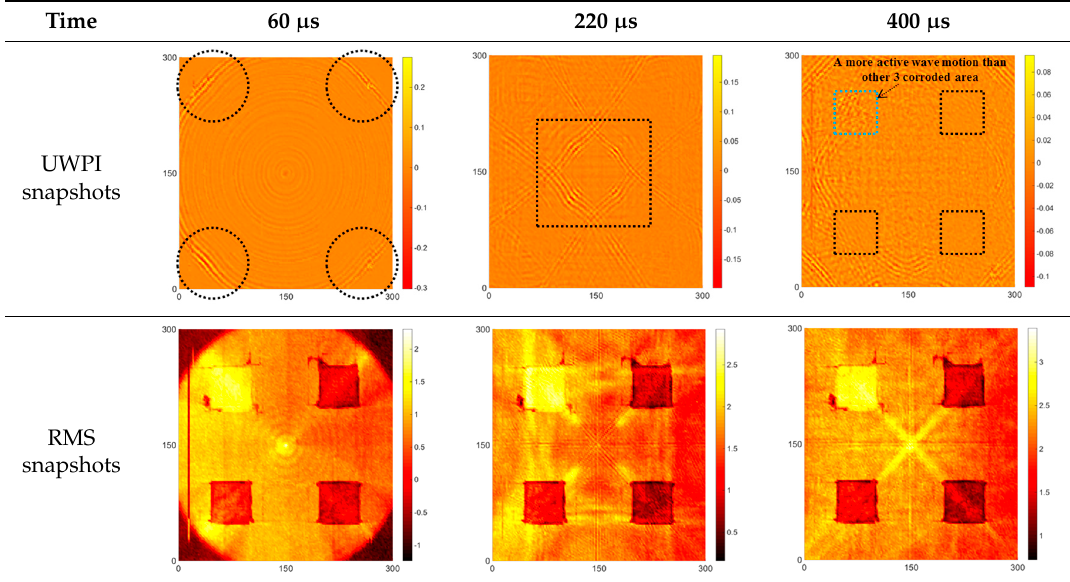
Table 2. UWPI and RMS snapshots of Specimen 1 front side at 60 μ s, 220 μ s and 400 μ s (the unit of x and y axis: mm).